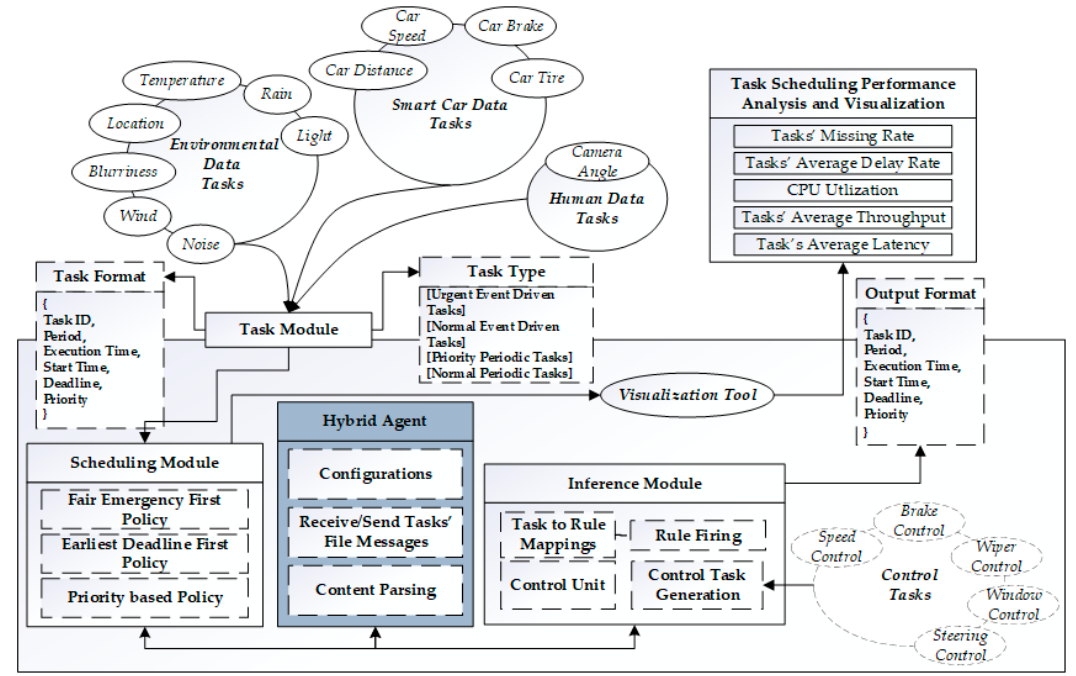
Figure 8. Hybrid agent’s based scheduling and inference mechanism.